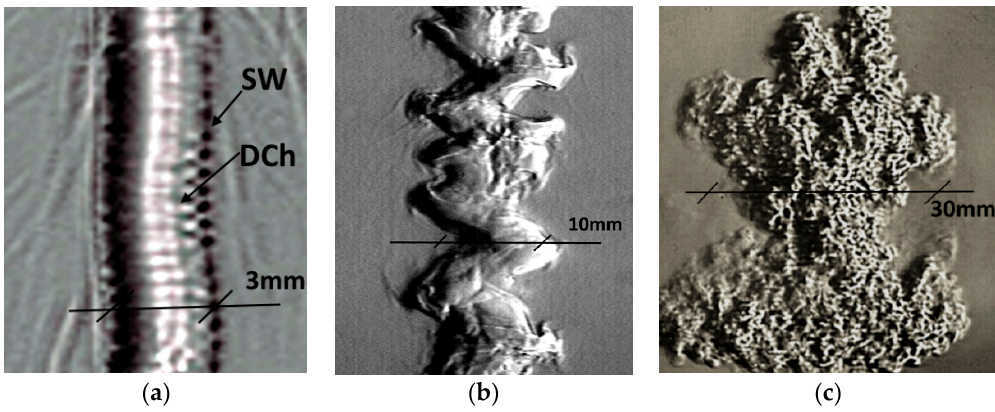
Figure 23. Schlieren images of gasdynamic instabilities developed due to pulse discharge generation in ambient air. ( a ) Time delay t ≈ 1 µs; ( b ) time delay t = 100 µs; ( c ) time delay t = 1 ms. “SW”—position of shock wave; “DCh”—interface of residual thermal cavity expanded after the electrical discharge.